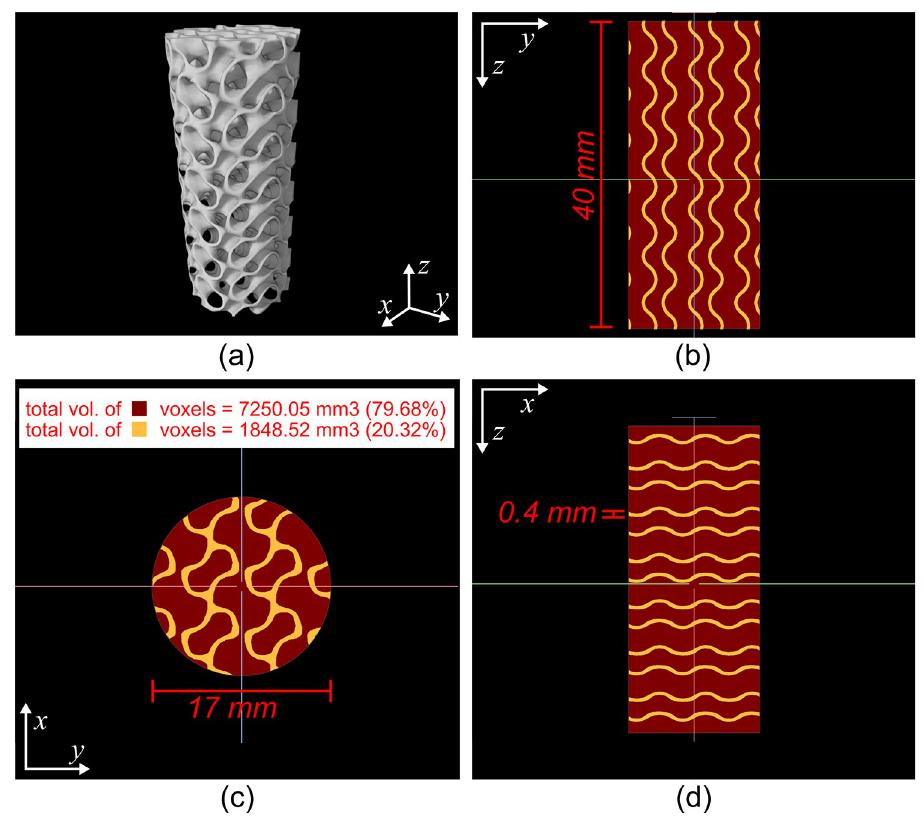
Fig 6. Computer-aided design (CAD) of the porous gyroid-based cylindrical titanium-alloy (Ti6Al4V) scaffold. (a) perspective view of 3D rendering of the CAD. (b) Trans-coronal synthetic slice of the porous cylinder CAD. (c) Trans-sagittal synthetic slice of the porous cylinder CAD. (d) Transaxial synthetic slice of the porous cylinder CAD. (b),(c), and (d) are color coded to depict the titanium-alloy (yellow) and internal porosity (red) regions of the scaffold.